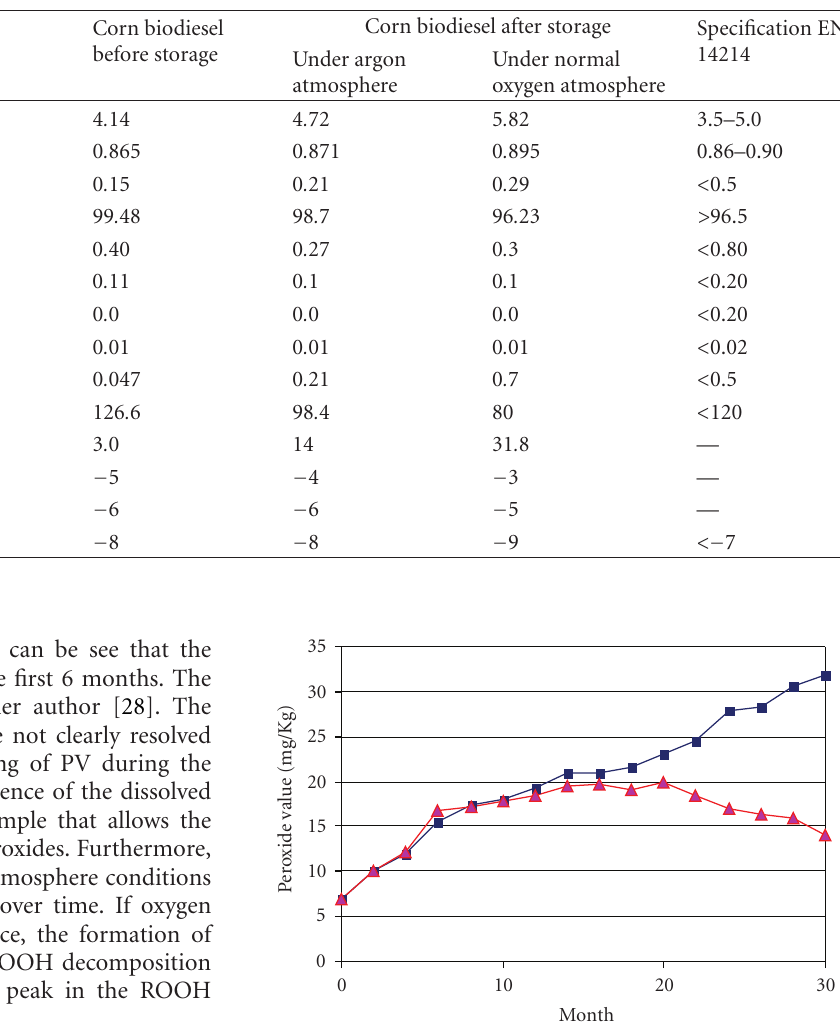
Figure 5: Variation in the peroxide value of corn oil biodiesel stored (cid:2) under normal oxygen atmosphere and (cid:3) under argon